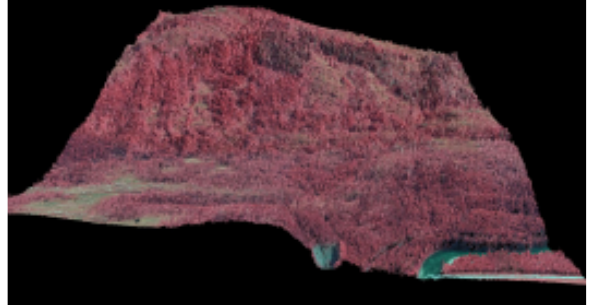
Figure 2. A 3D view of an example tile of photogrammetric point cloud with false colour (IR, R and